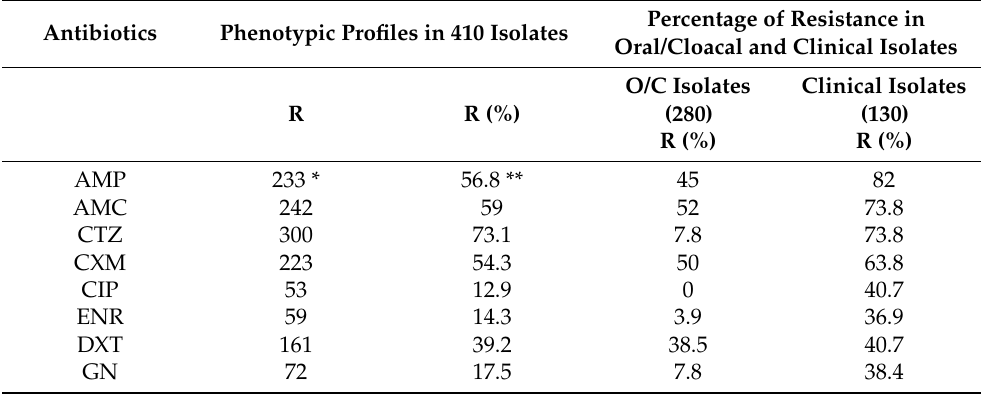
Table 2. Summary of the resistance patterns in all bacterial isolates (n = 410) and percentages of resistance in O/C or clinical isolates.